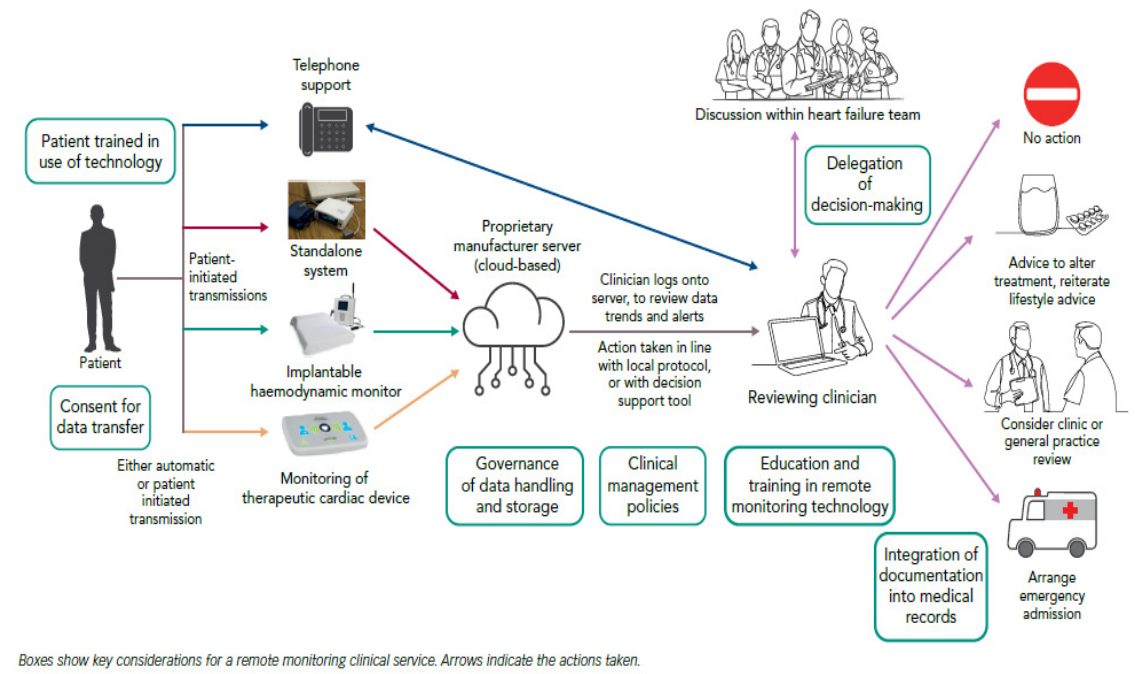
Figure 1. Remote monitoring system.